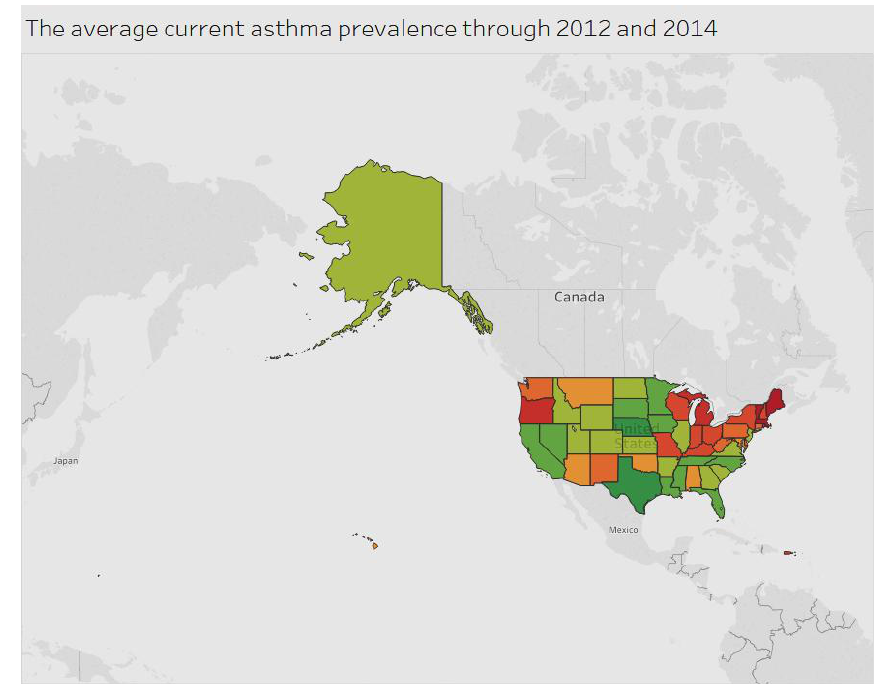
Figure 3. Asthma by state.